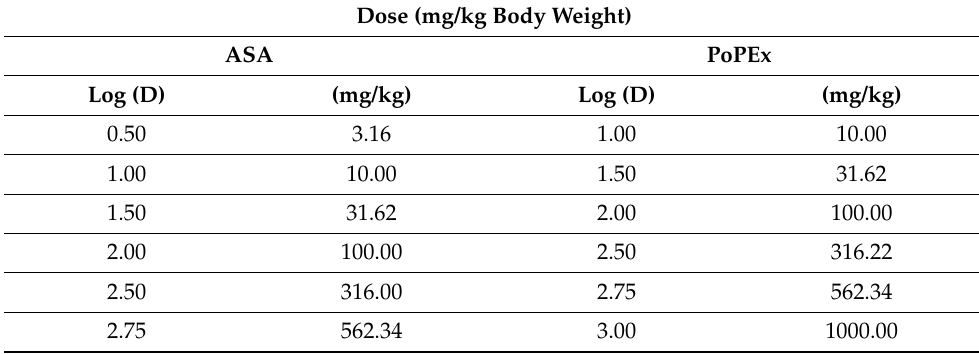
Table 4. Doses from dose–response curves of PoPEx and ASA before administration of 2%